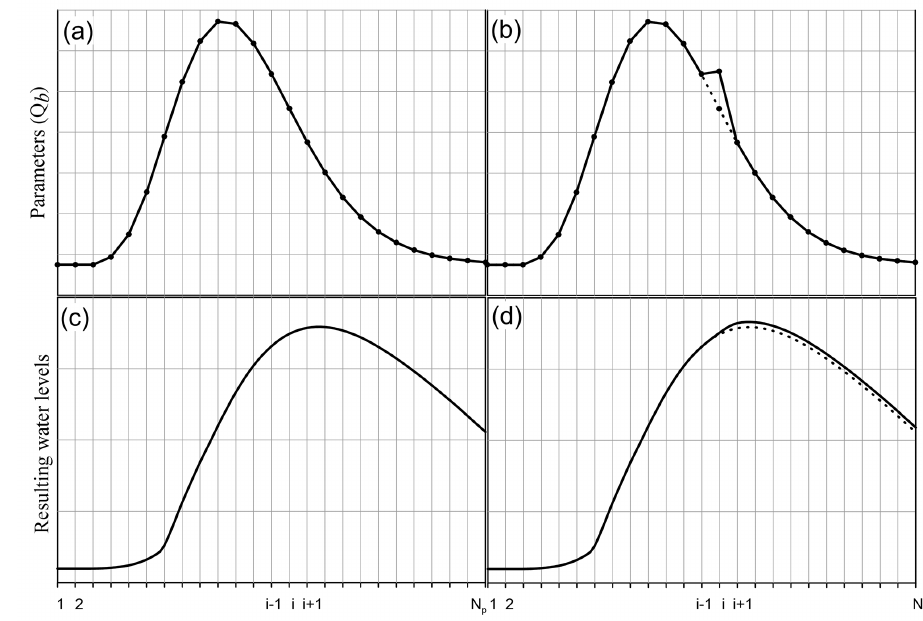
Figure 2. Example of the base run (a) and of the run i for the Jacobian matrix evaluation (b) .